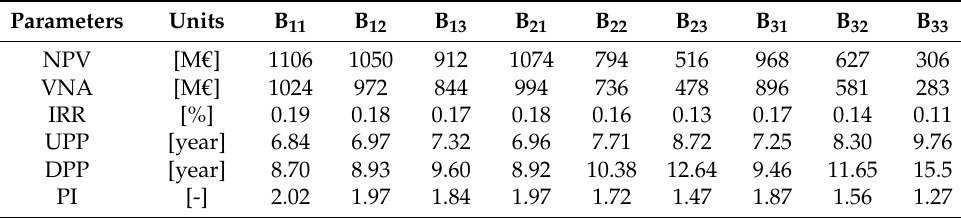
Table 14. The economic assessment of the CFPP system with a single-stage of membrane technology (vacuum pump used).